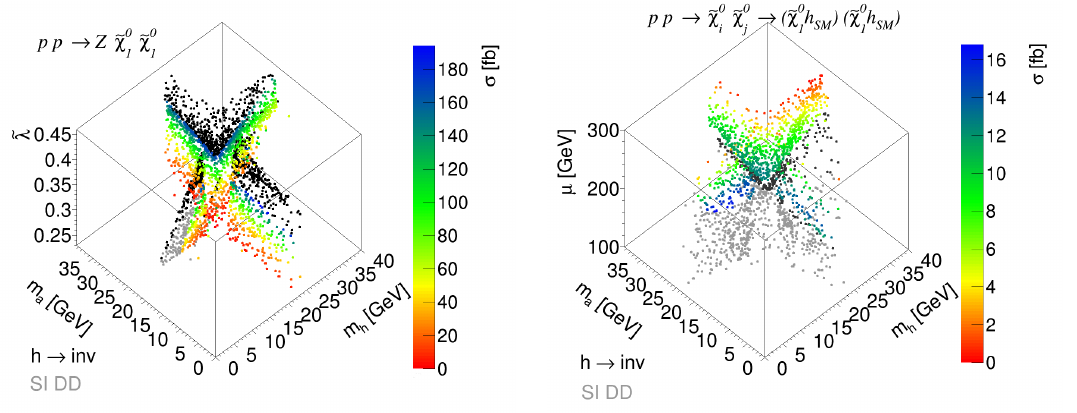
Figure 18: Mono- Z (left) and mono-Higgs-pair (right) cross section versus the singlet-like pseudoscalar and scalar masses and the singlino–higgsino mixing param- eter. All points fulfill the relic density, chargino mass, and invisible Z decay bounds. The effects of the invisible Higgs decays and spin-independent direct detection are shown in